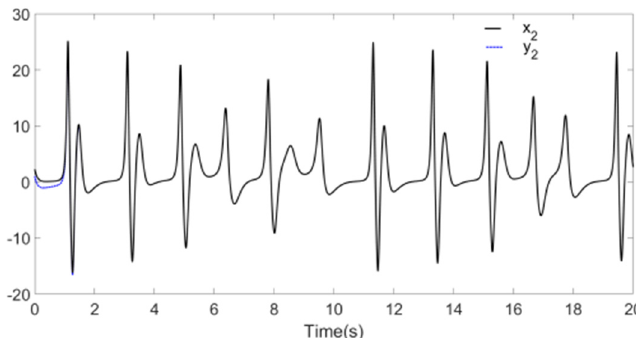
Figure 8. Synchronization of 1